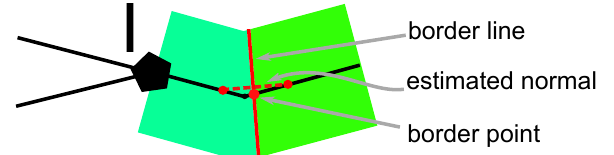
Figure 8: Creating the border line by cutting the section with local estimation of